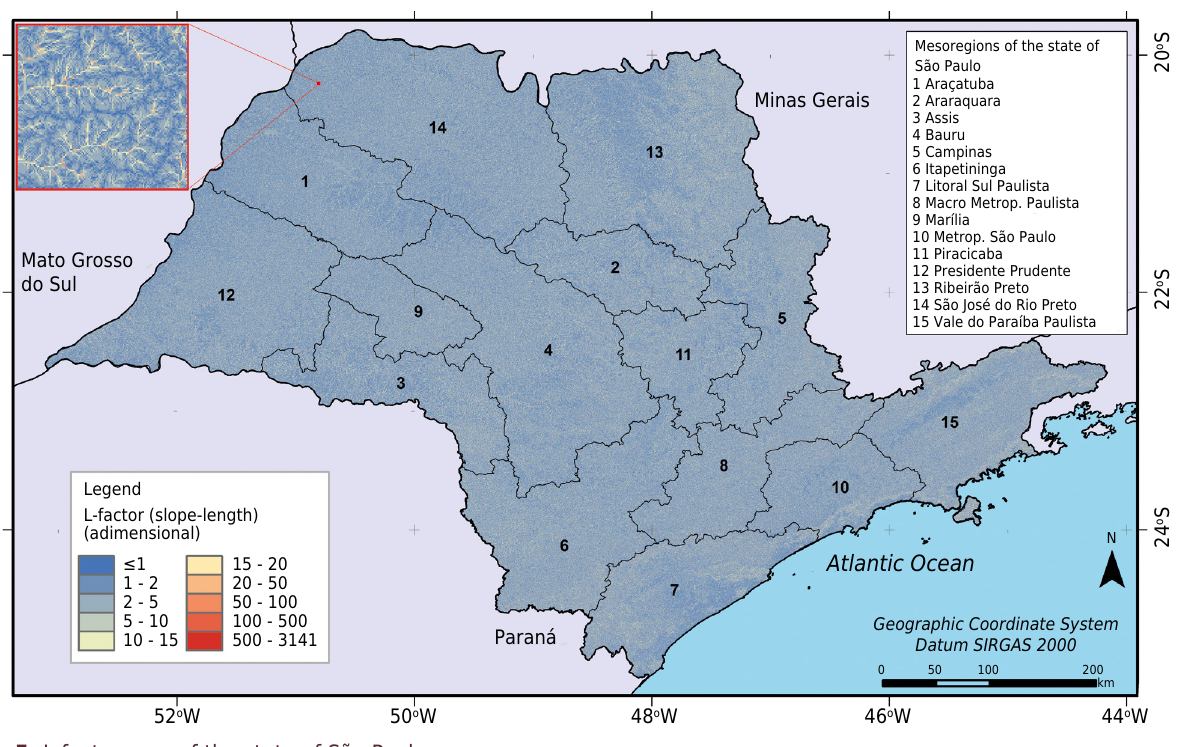
Figure 5. L-factor map of the state of São Paulo.